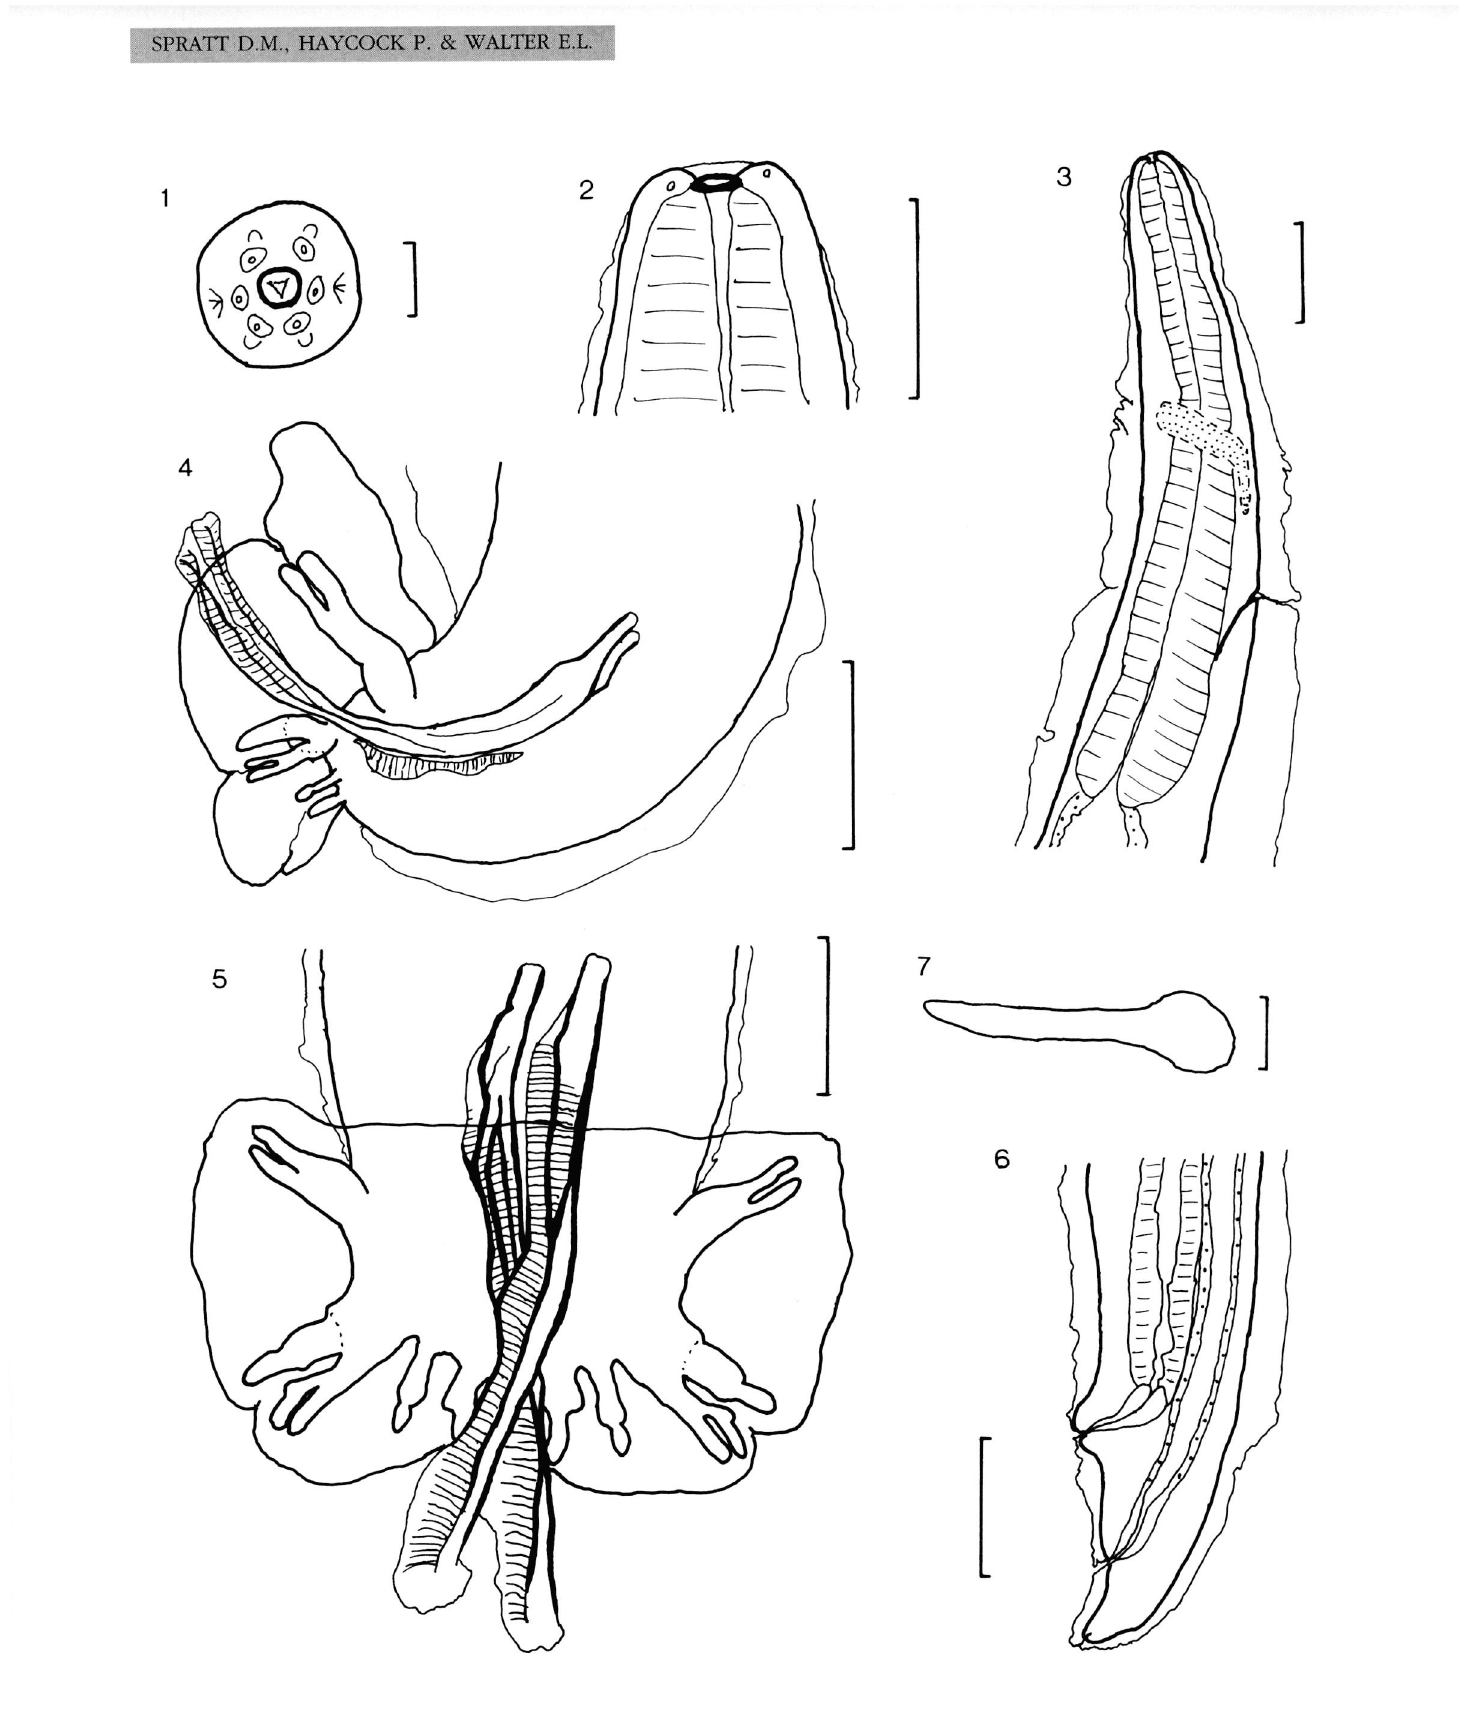
Figures 1-7. - Gallegostrongylus australis n.sp. from Rattus fuscipes. 1. Cephalic end, en face view, bar =10 pm. 2. Female anterior end sho­ wing shallow buccal capsule, lateral view, bar = 30 um. 3. Female anterior end, lateral view, bar = 50 um. 4. Male caudal end, lateral view, bar = 50 pm. 5. Male bursa and spicules, ventral view, bar = 30 u m. 6. Female caudal end, lateral view, bar = 50 um. 7. Gubernaculum, lateral view, bar = 10 um.